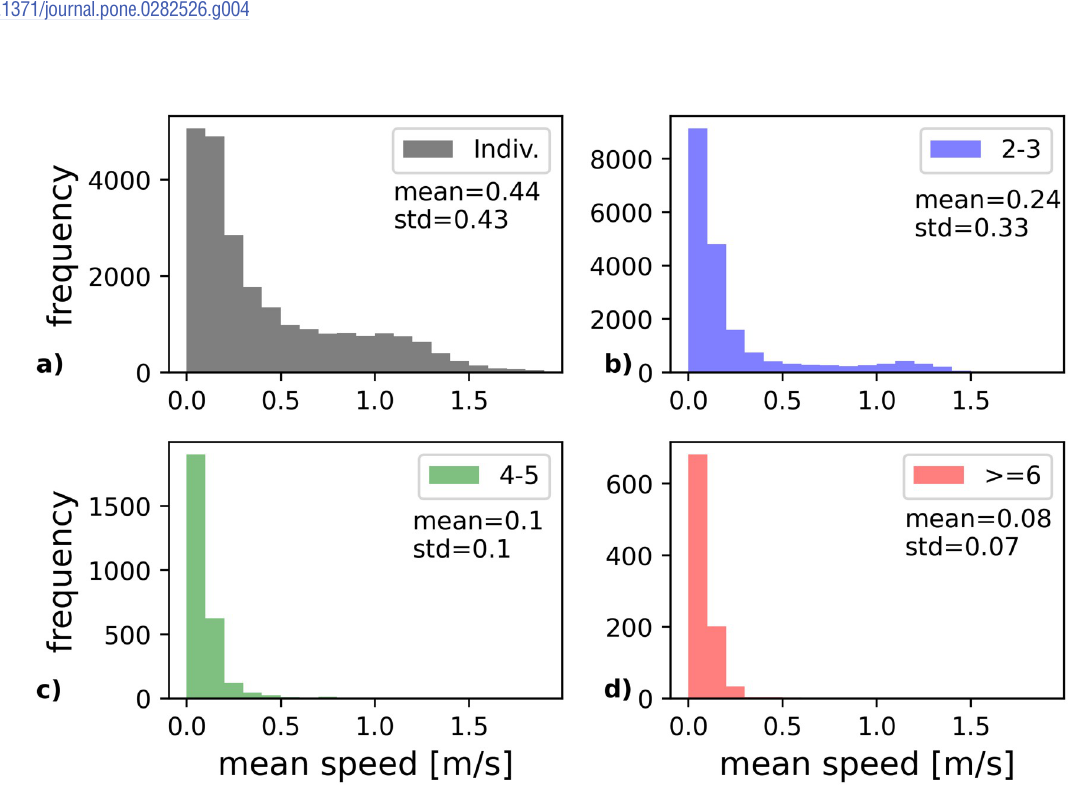
PLOS ONE | https://doi.org/10.1371/journal.pone.0282526 March 15,